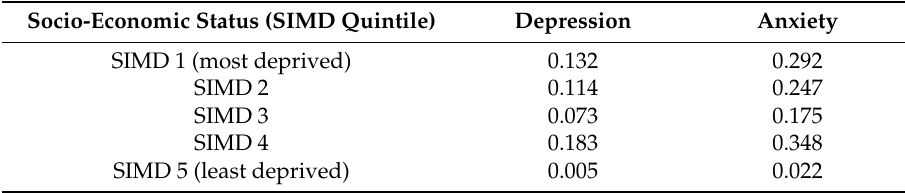
Table 4. Correlation coefficients (r 2 ) of association between mean change in neighbourhood perceptions and predicted mean change in HADS scores after adjustment by socio-economic status 1